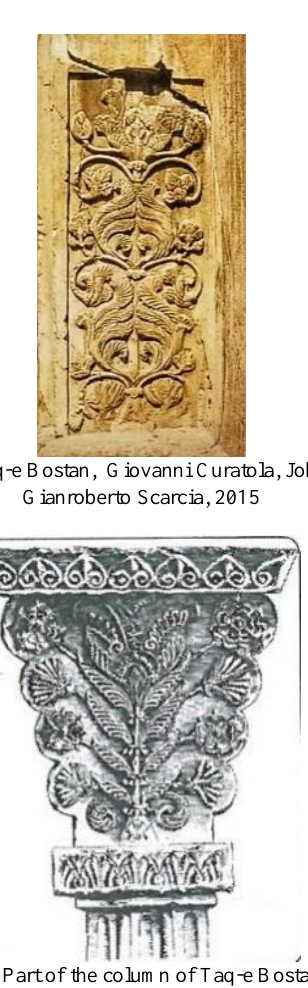
Figure 16 - Part of the column of Taq-e Bostan, Majid Azadbakht, 2018